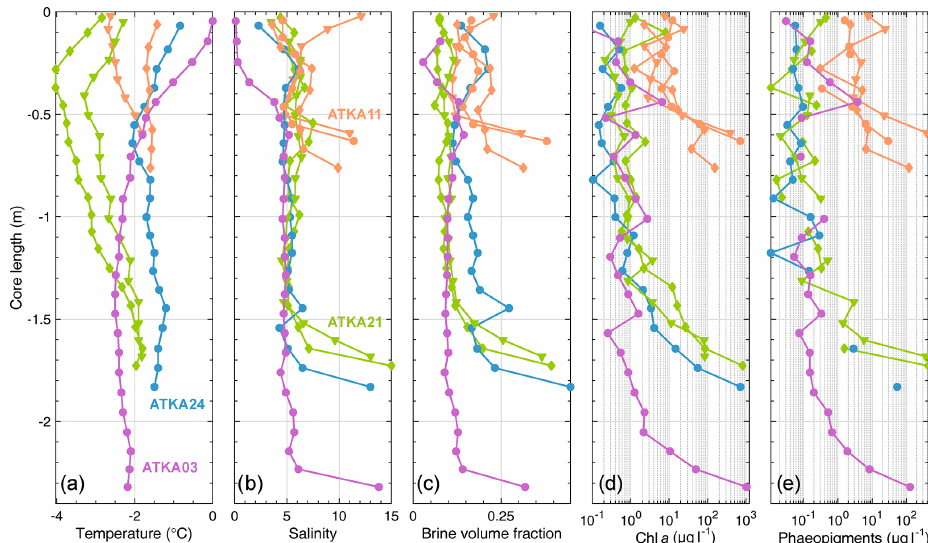
Figure 10. Sea-ice physical and biological properties from cores obtained at different fast-ice sampling sites in November–December 2012 (after Hoppmann et al.,